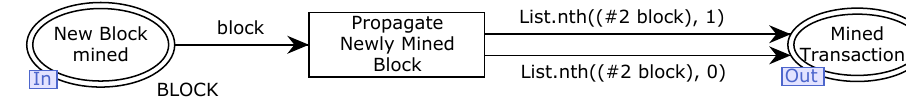
Figure 16. ‘Propagate Mined Blocks’ sub-module of the BlockVoke CPN